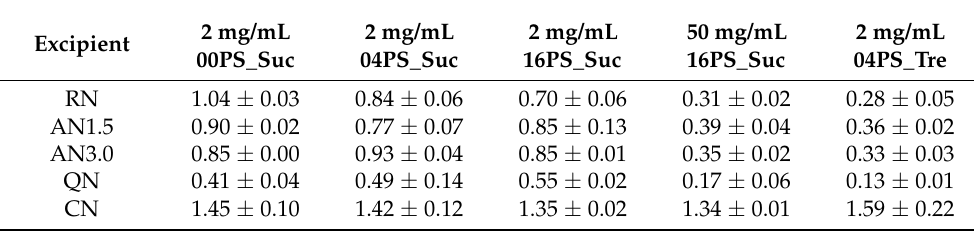
Table 3. Residual moisture levels of the freeze-dried formulations in [% w / w ]. n = 2, values represent the mean value and the corresponding standard